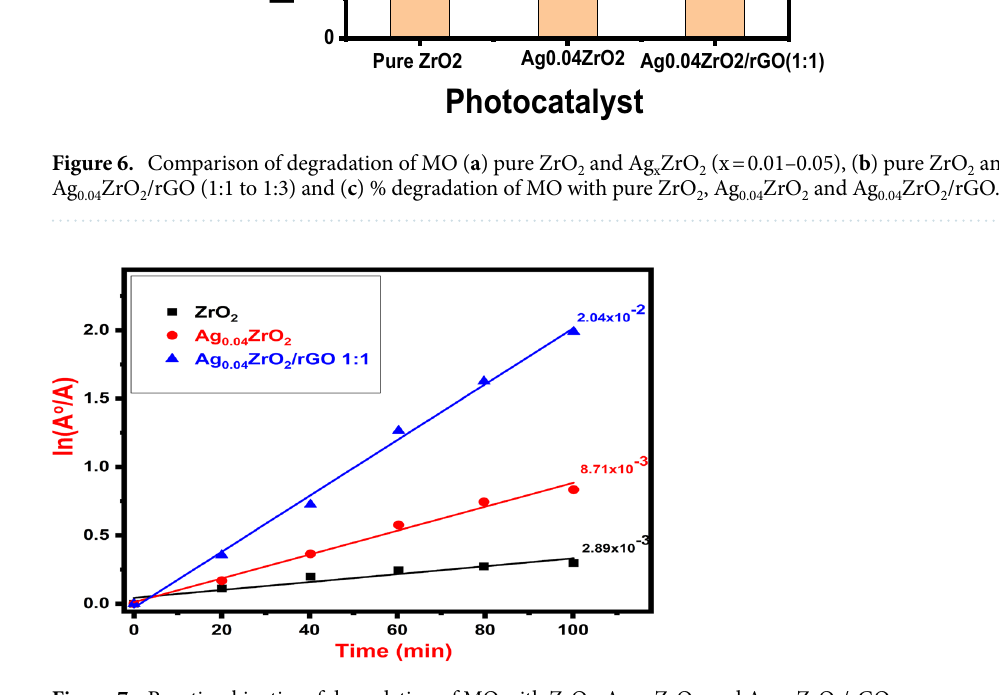
Figure 7. Reaction kinetics of degradation of MO with ZrO 2 , Ag 0.04 ZrO 2, and Ag 0.04 ZrO 2